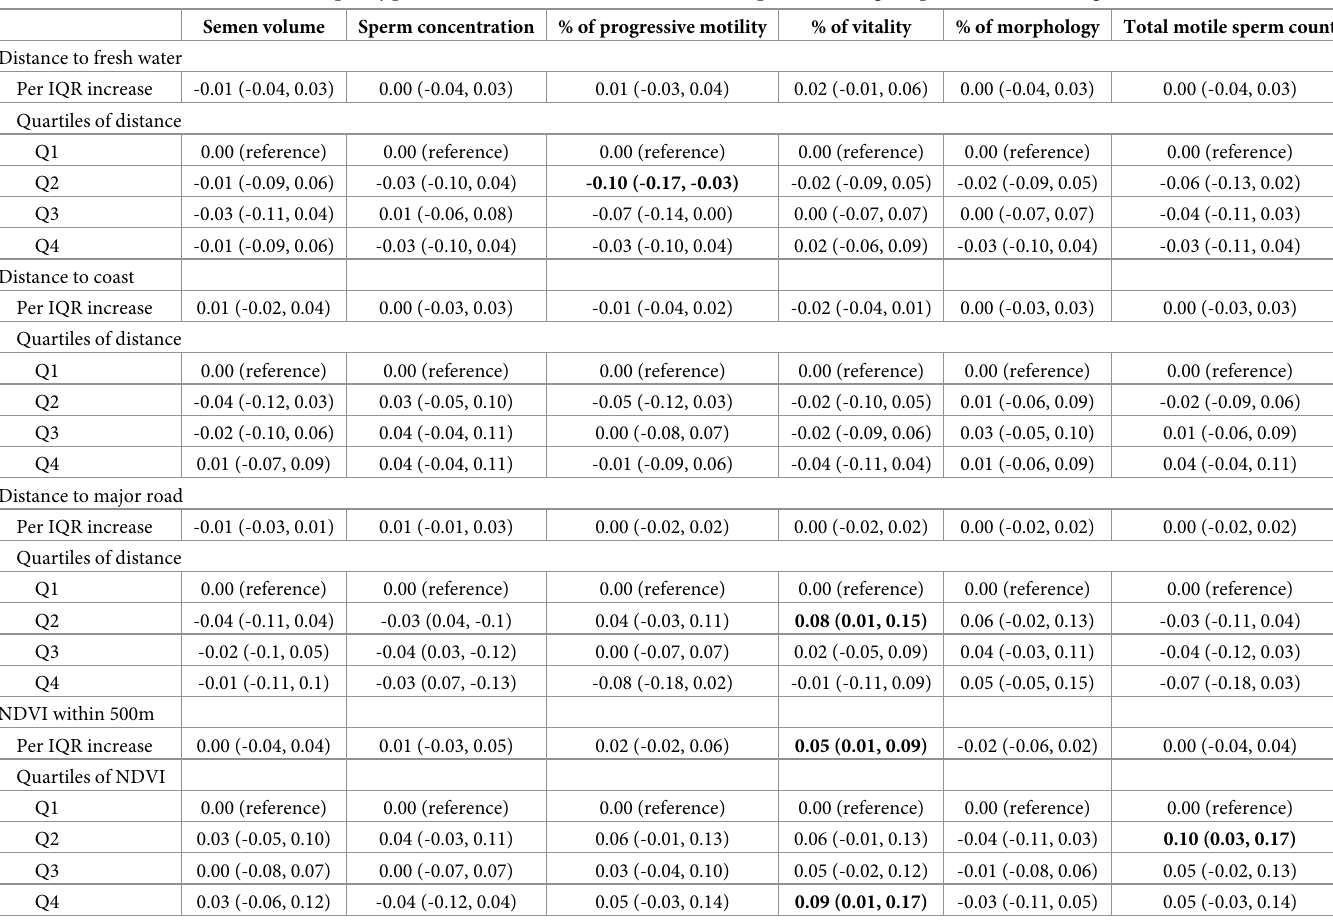
Table 2. Association between six semen quality parameters and four built environment components in single exposure models among 5,886 Korean infertile